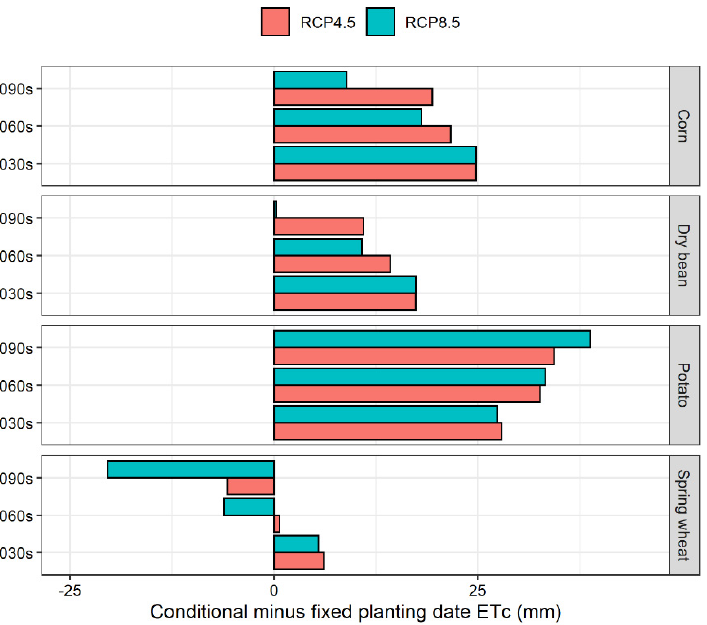
Figure 8. Difference in projected future crop evapotranspiration (ETc) between conditional and fixed planting date (positive values means conditional planting date mode has higher ETc than fixed planting mode, and vice versa).